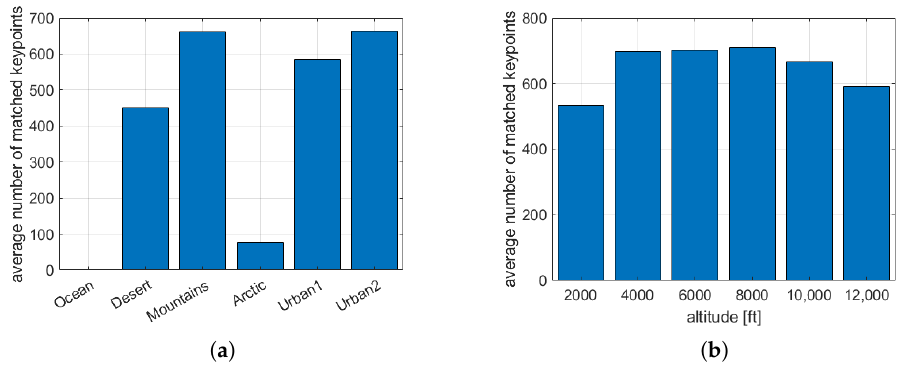
Figure 15. The average number of matched keypoints for: ( a ) different scenes, ( b ) different altitudes.